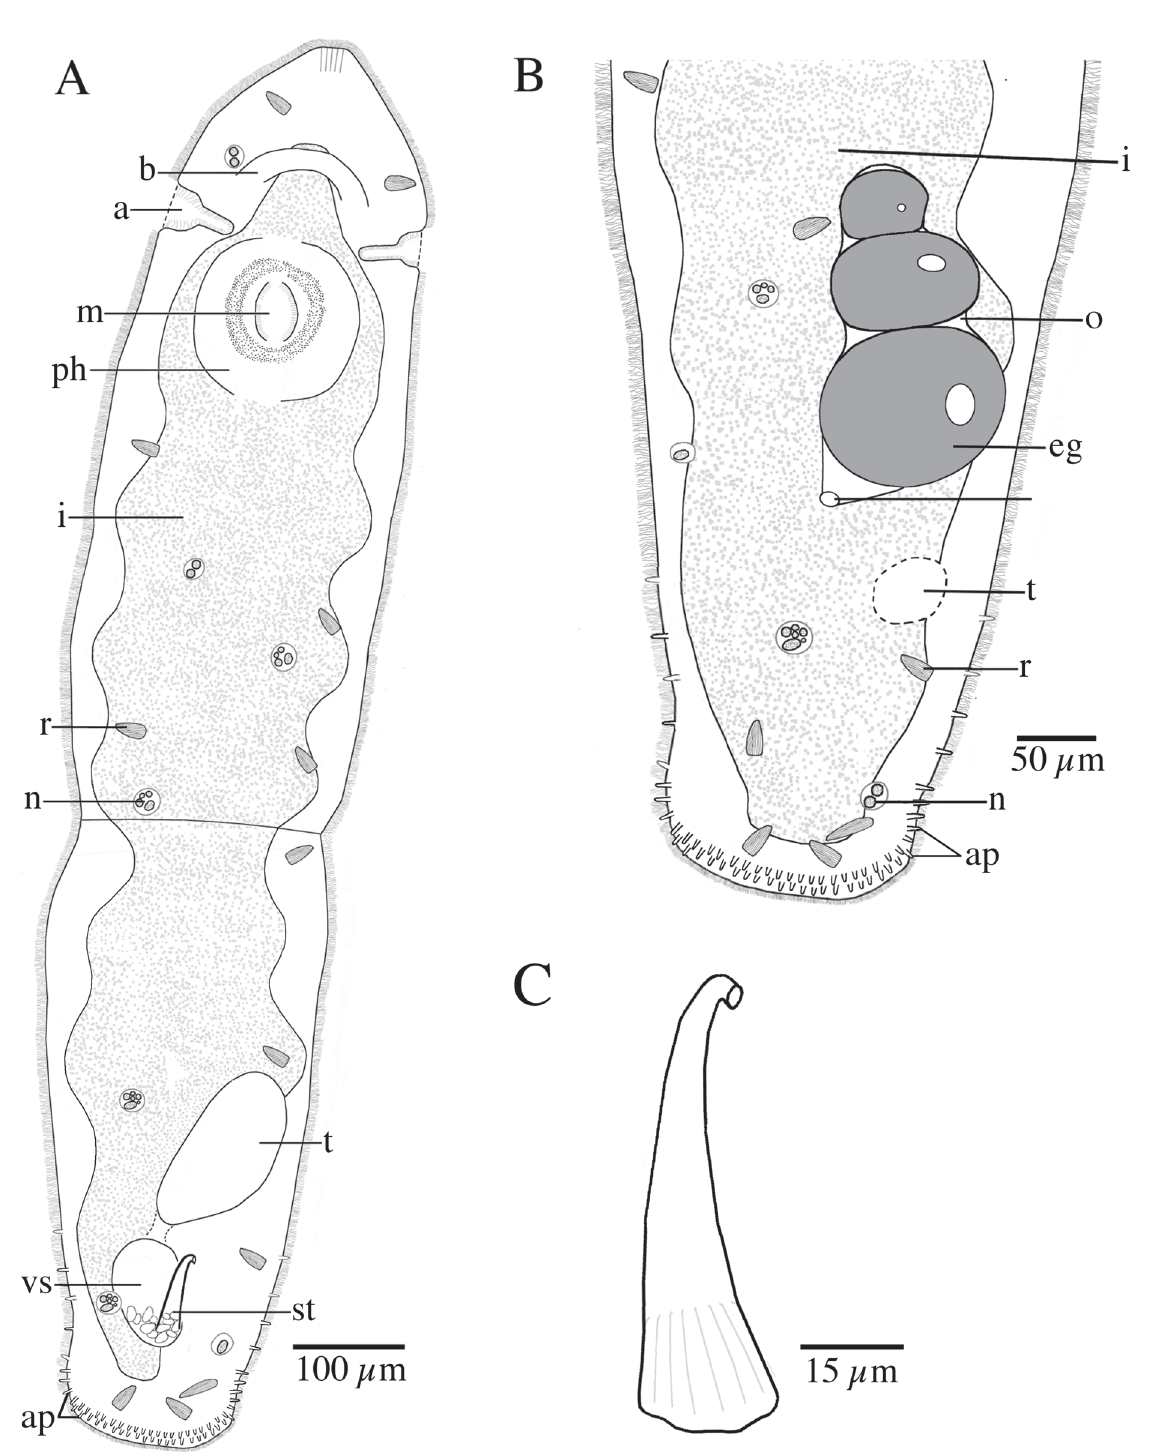
Fig. 3 . Microstomum edmondi sp. nov., composite sketches. A . Entire body of male specimen. B . Posterior end of female specimen. C . Stylet. Abbreviations: a = auricles (ciliary pits); ap = adhesive papillae; b = brain; eg = egg; i = intestine; m = mouth; n = nematocysts; o = ovary; ph = pharynx; r = rhabdites; st = male stylet; t = testis; vs =